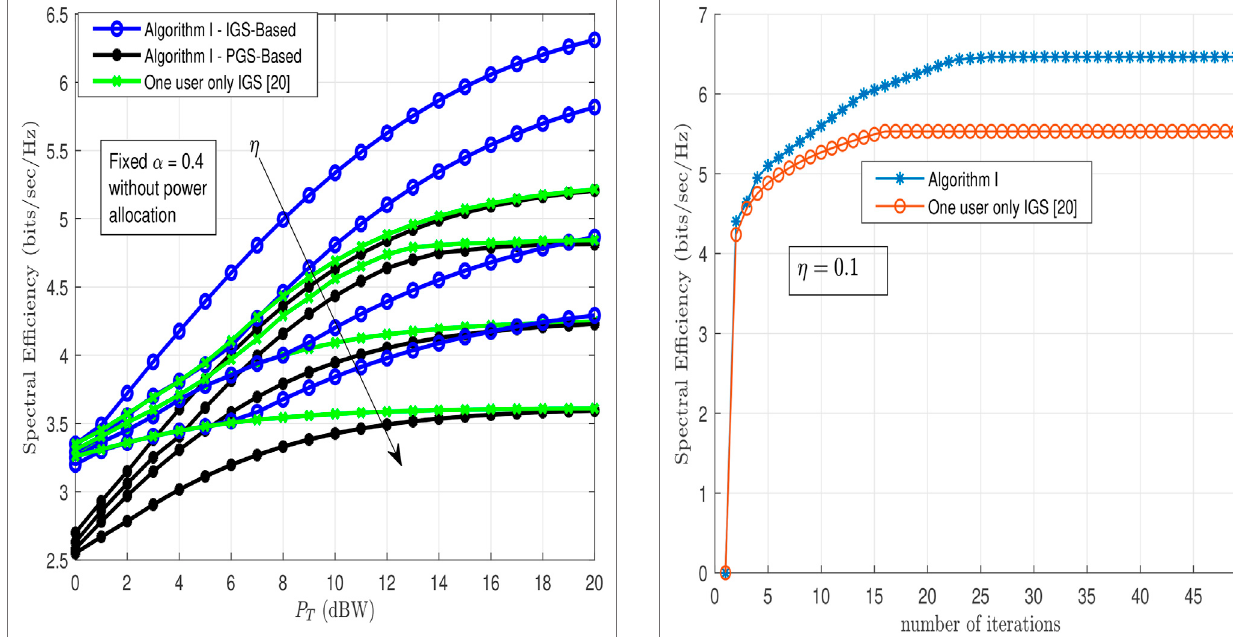
FIGURE 6 | Comparison between the convergence of the Algorithm 1 and theAlgorithmin(AbuMahadyet al.,2019) intermsofnumber ofiterations at η =